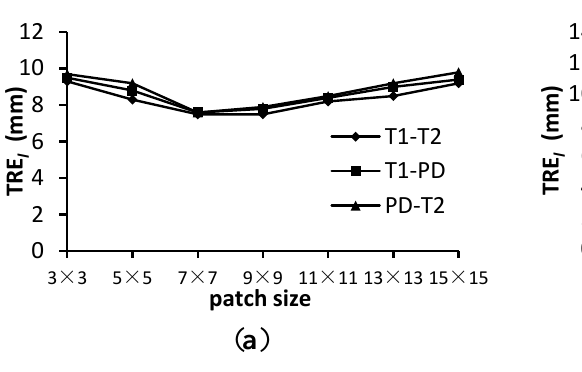
(in mm) for the wldNSSD and wldWSSIM using various patch sizes. ( a ) wldNSSD; ( b )